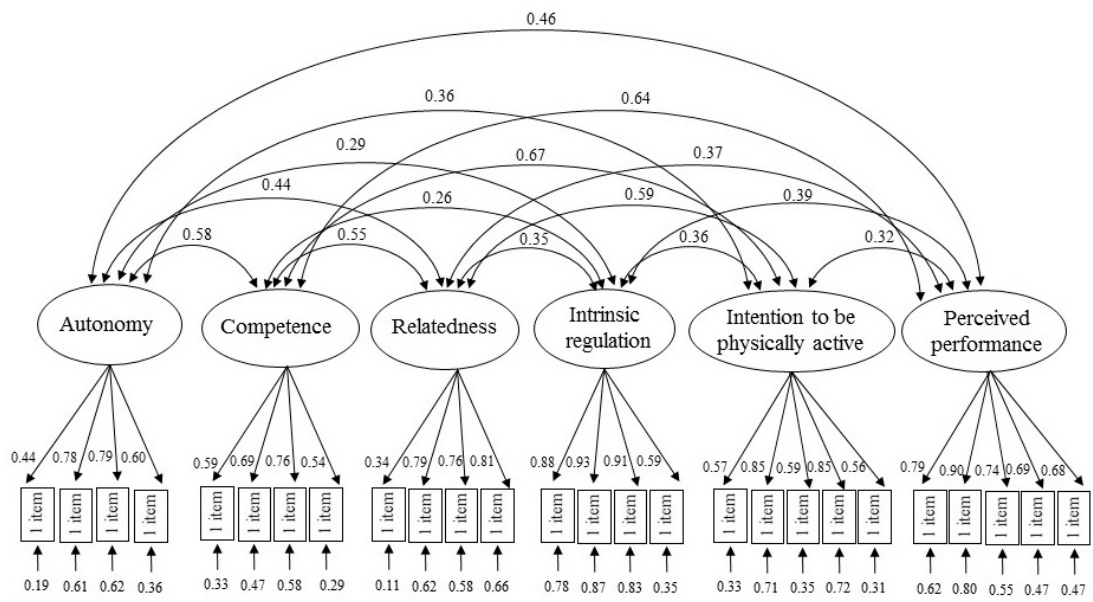
Figure 2. Measurement model.